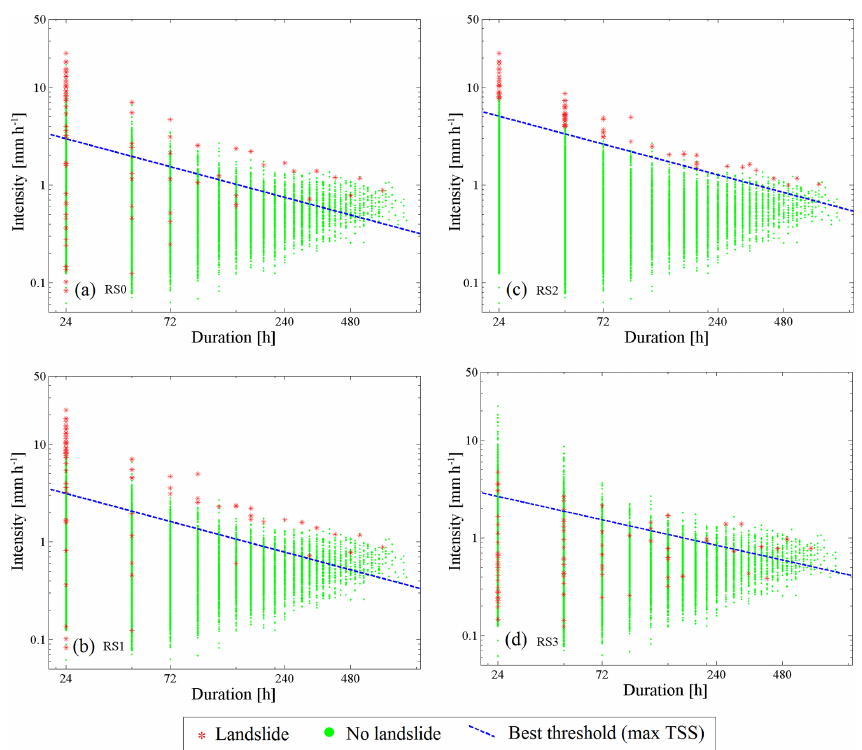
Figure 7. Scatter plot, on the double-logarithmic rainfall duration–intensity plane, of triggering and non-triggering events for daily data with aggregation shift as in the Italian rainfall databases. Separation algorithm parameters are u min = 1 day, s min = 0mm. Thresholds correspond to the maximum performance in terms of true skill statistic. The plots show outcomes relative to (a) reference RS0 and (b–d) various erroneous reporting scenarios (RS1, RS2,